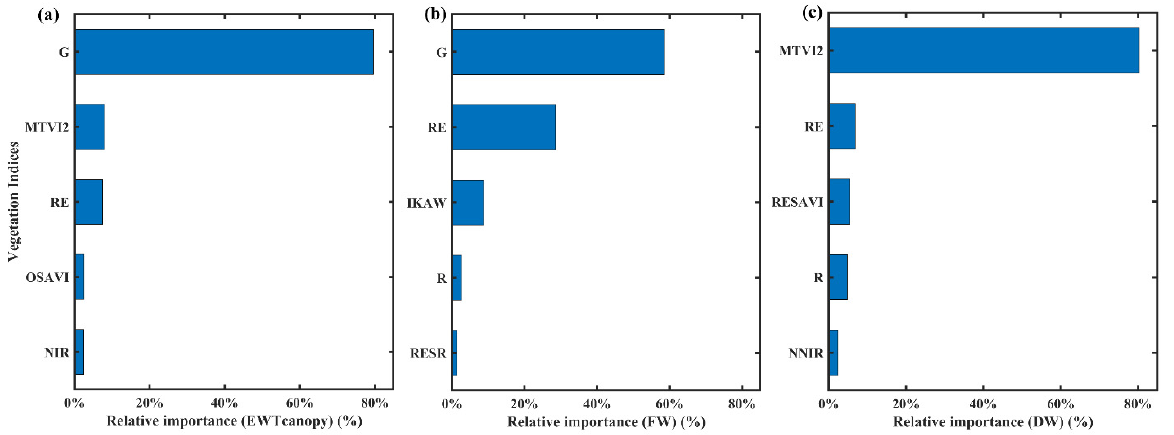
Figure 6. Feature importance selection of vegetation indices (VIs) based on the decision tree for EWT canopy ( a ), FW ( b ), and DW ( c ).